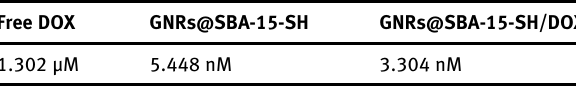
Figure 12: (a) Cell viabilities of the A549 cells after incubation with various concentrations of GNRs@SBA-15-SH and GNRs@SBA-15-SH/DOX,atconcentrationof 6.25 nM ** p = 0.0037 and at concentration of 12.5 nM ** p = 0.004 (b) free DOX, **** p ˂ 0.0001, n = 3.